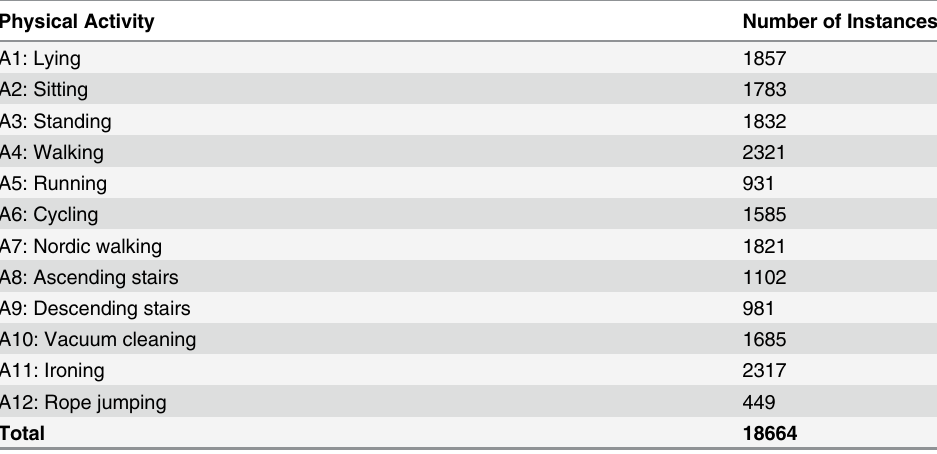
Table 1. Number of instances per activity.